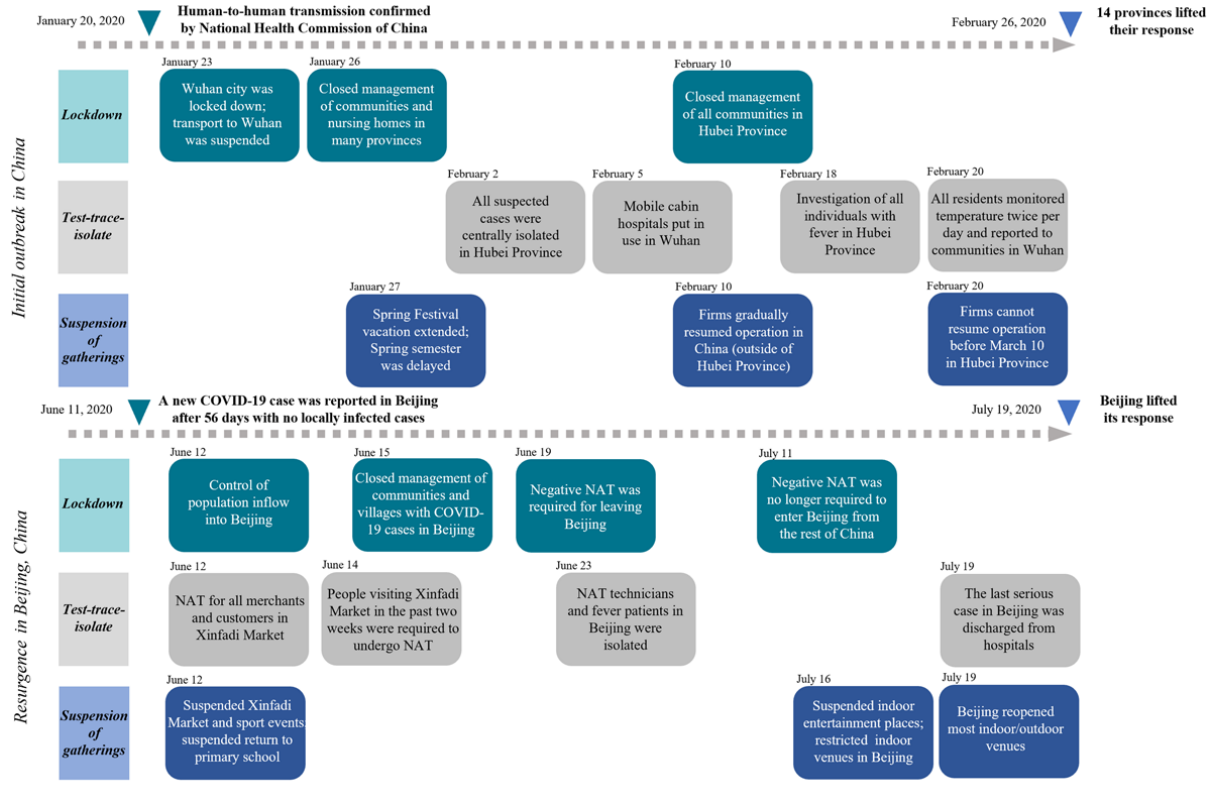
Figure 1. Timeline of containment measures during the initial outbreak and the resurgence of COVID-19 in China. Containment measures relevant to the lockdown, the test-trace-isolate measure, and suspension of gatherings are shown in chronological order. NAT: nucleic acid